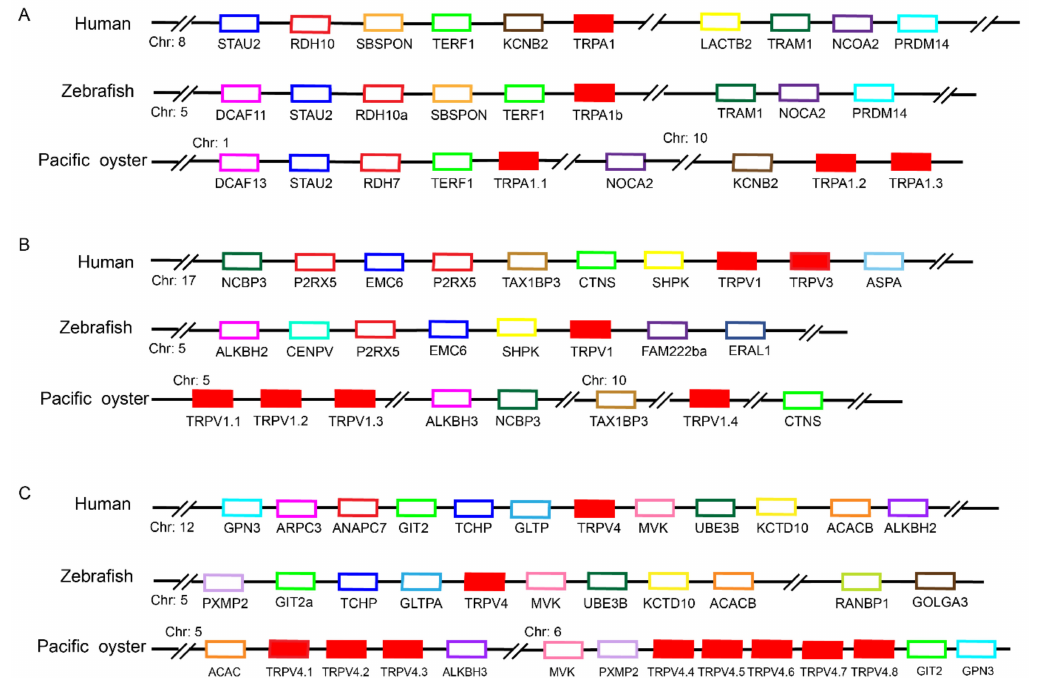
Figure 3. Syntenic analyses of ( A ) TRPA1, ( B ) TRPV1, and ( C ) TRPV4 in C. gigas . The TRP genes were highlighted in solid red box, and their neighboring genes were indicated by different color boxes with gene symbols. The syntenic information of TRPs for other species was from Genomicus (v96.01).